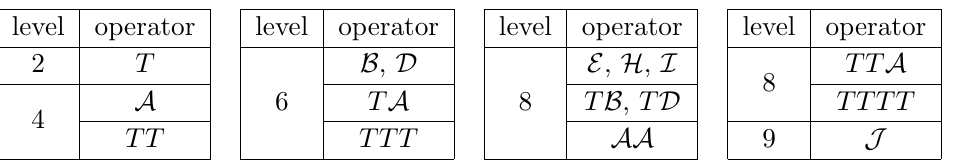
Table 2. The holomorphic nonidentity quasiprimary operators to be considered in this paper for CFT n and up to level 9. We have omitted the replica indices and their constraints, which can be easily (cid:12)gured out and can also be found in